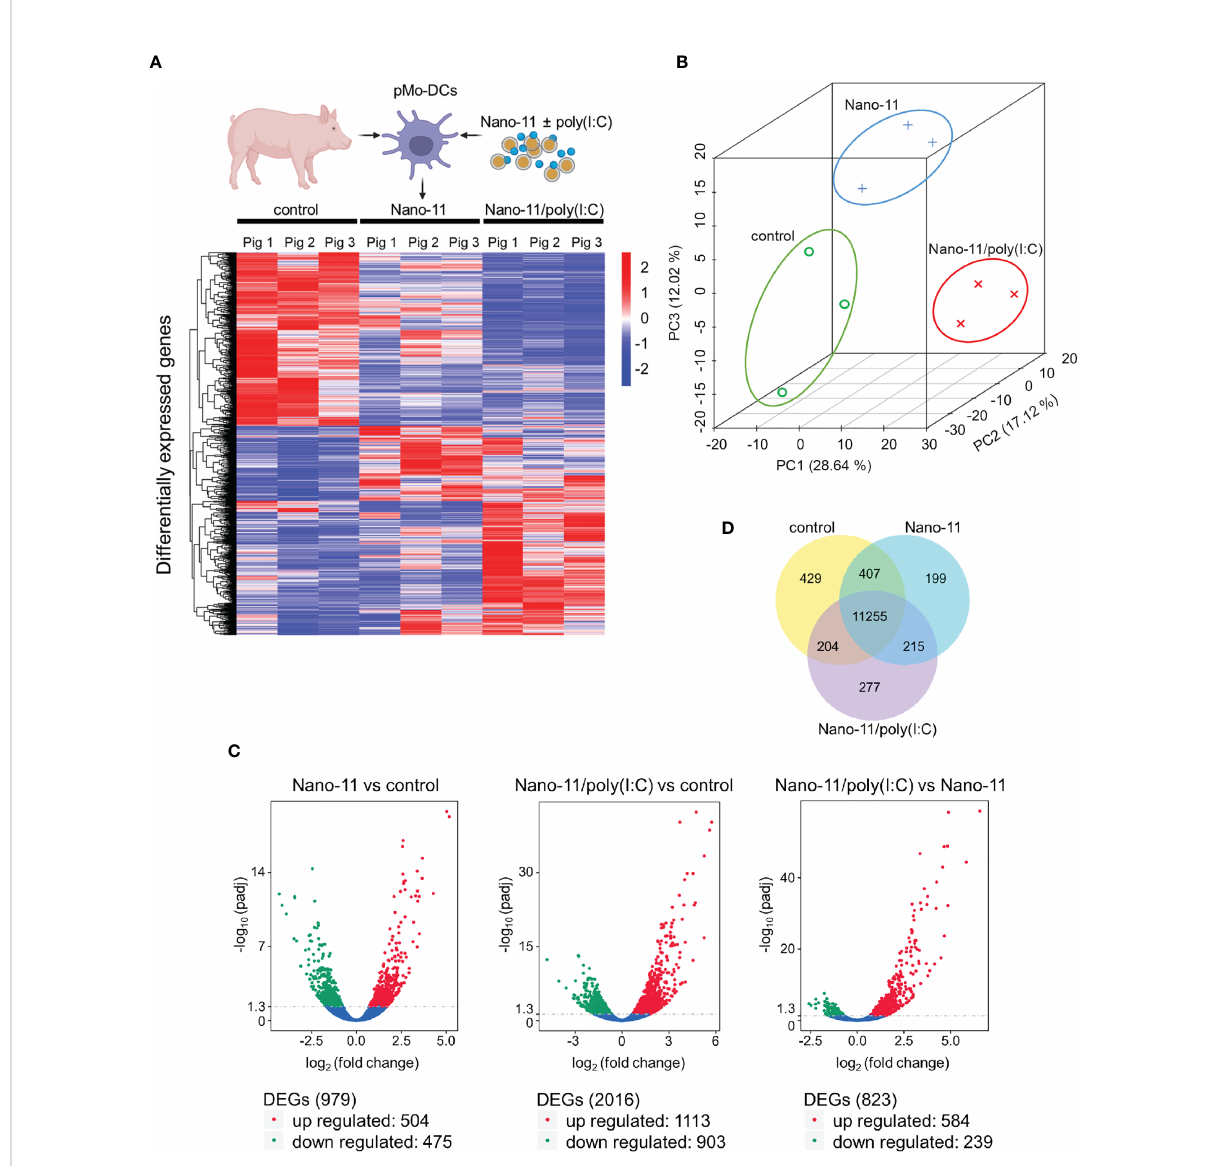
FIGURE 2 Transcriptional pro fi ling of porcine Mo-DCs (pMo-DCs) stimulated with Nano-11 and Nano-11/poly(I:C) for 3 hours. (A) Hierarchical clustering heat map representing differential expression by FPKM cluster analysis. The color range indicates log10(FPKM + 1) values for high gene expression (red) levels, and genes with low expression (blue) levels. The schematic fi gure was created with BioRender.com (B) Principal component analysis (PCA) reveals clustering of DEGs from the control, Nano-11, and Nano-11/poly(I:C) groups. (C) Volcano plots illustrating differentially expressed genes (DEGs) after Nano-11 ± poly(I:C) stimulation. Upregulated DEGs are in red and downregulated DEGs in green. (D) Venn diagram depicts the number of genes that are uniquely expressed in unstimulated pMo-DCs (control), Nano-11, and Nano-11/poly(I:C) stimulated pMo-DCs, with the overlapping portions representing the number of genes that are co-expressed between the